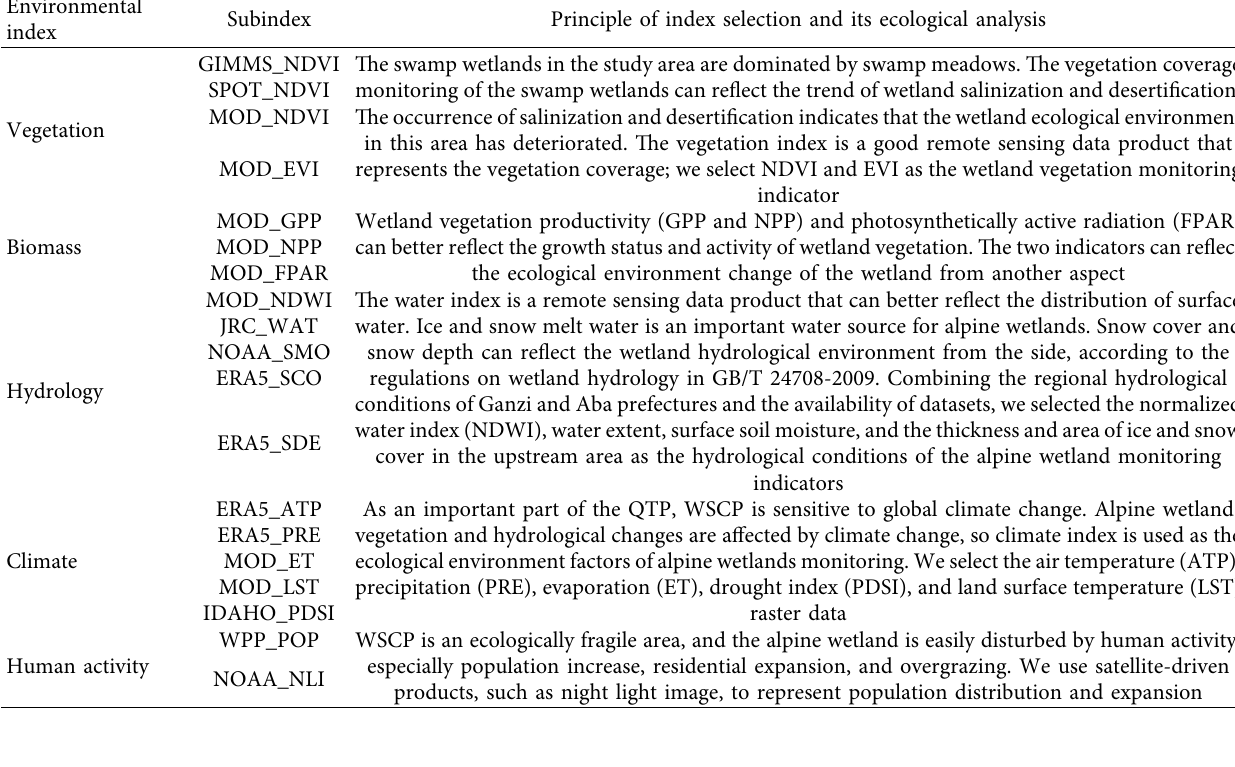
Table 2: Monitoring index system of EEAW in western plateau of Sichuan province.